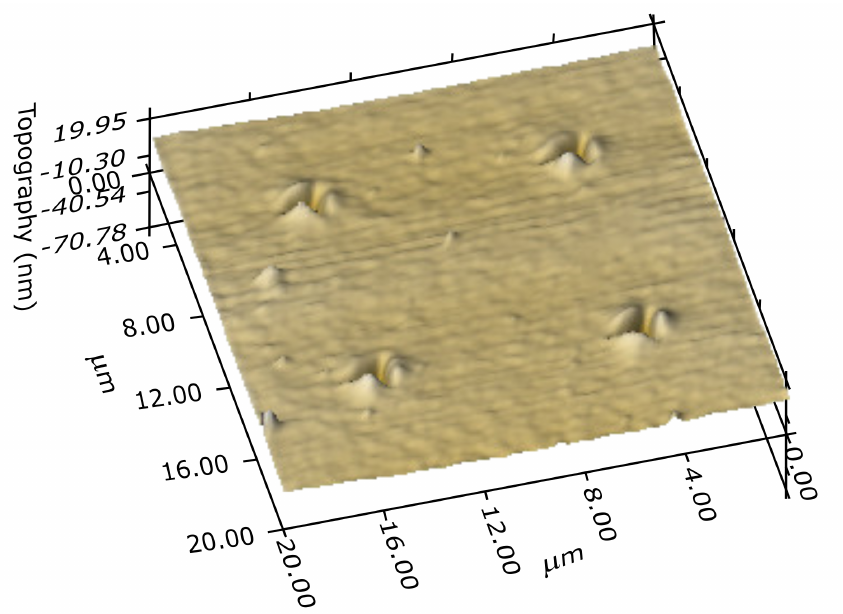
Figure 4. 3D image of the film surface with four indentation prints made at 3